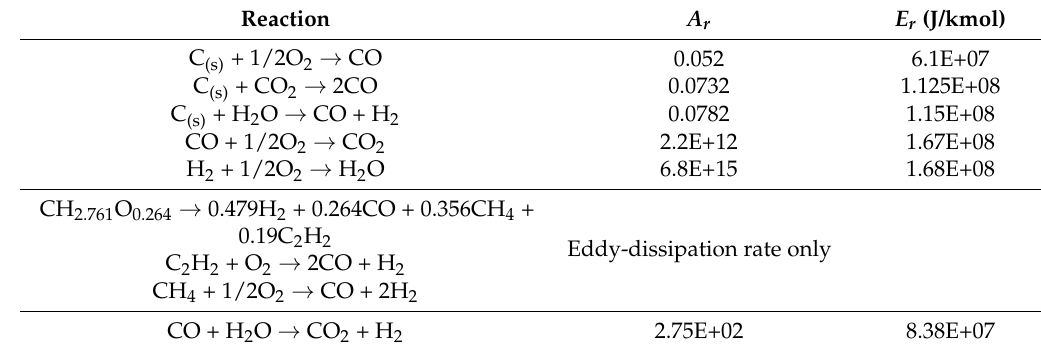
Table 1. Global reaction rate constants in this